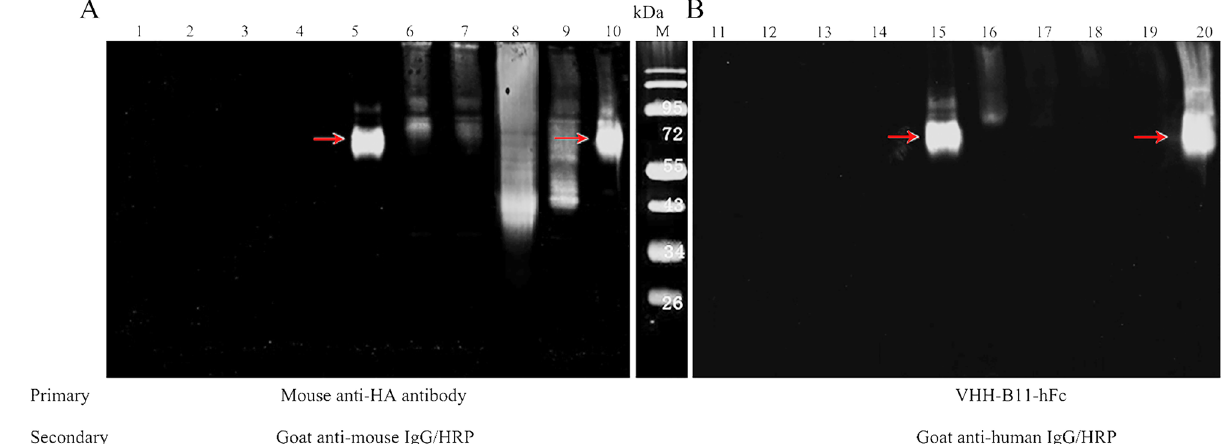
Figure 7. Immunoblot assay and epitope verification. Immunoblot assay was performed to verify the predicted epitope between PCSK9 and VHH-B11-Fc. PCSK9 and its deletants were loaded in the following sequence in groups of five samples (lanes 1–5 and 11–15: supernatants; lanes 6–10 and 16–20: cell precipitation lysate): PCSK9-Δ1 (383–405), PCSK9-Δ2 (429–449), PCSK9-Δ3 (153–449), PCSK9-Δ4 (450–692), and wild-type PCSK9 (red arrow). ( A ) The anti-HA Ab was used as primary Ab to check whether PCSK9 was expressed intracellularly (lanes 1–5) and extracellularly (lanes 6–10). The HRP-tagged goat anti-mouse IgG was used as the secondary antibody. ( B ) The B11-Fc Ab was used as a primary Ab to check whether PCSK9 and the deletants could still interact specifically with B11-Fc (lanes11–20). The HRP-tagged goat anti-human IgG was used as the secondary